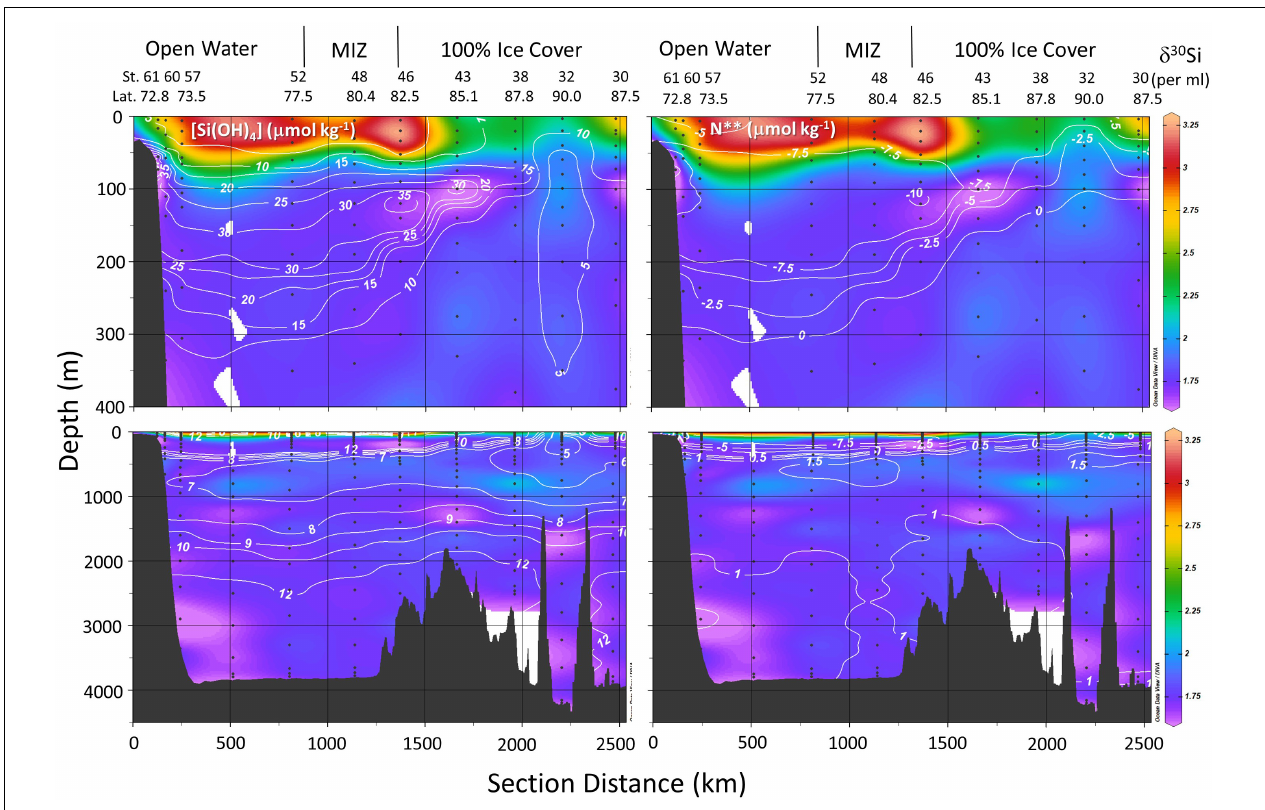
FIGURE 4 | Distribution of δ 30 Si(OH) 4 (color map) relative to line contours of silicic acid concentration in µ mol kg − 1 (left panels) and N** in µ mol kg − 1 (right panels) in the upper 400 m (top panels) and from surface to the sea floor (lower panels) on GN01 as a function of section distance. Section distance runs from station 61 in the Chukchi Sea to station 32 at the pole and then to station 32 in the Makarov basin ( Figure 1 ) crossing the Lomonosov Ridge twice. Station numbers, station latitude, ice cover, and the location of the Marginal Ice Zone (MIZ) are indicated above each upper panel. Abbreviations denote the Canada Basin (CB), Makarov Basin (MB), and Amundsen Basin (AB). Bathymetric features include the Alpha Ridge (AR) and Lomonosov Ridge